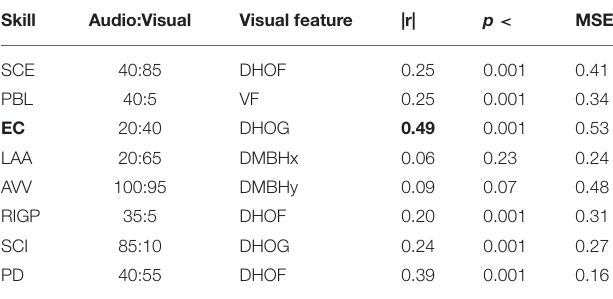
TABLE 6 | Best GP regression model results for each presentation delivery skill (such as SCE, PBL, etc.) using Fusion of Audio-Visual features.